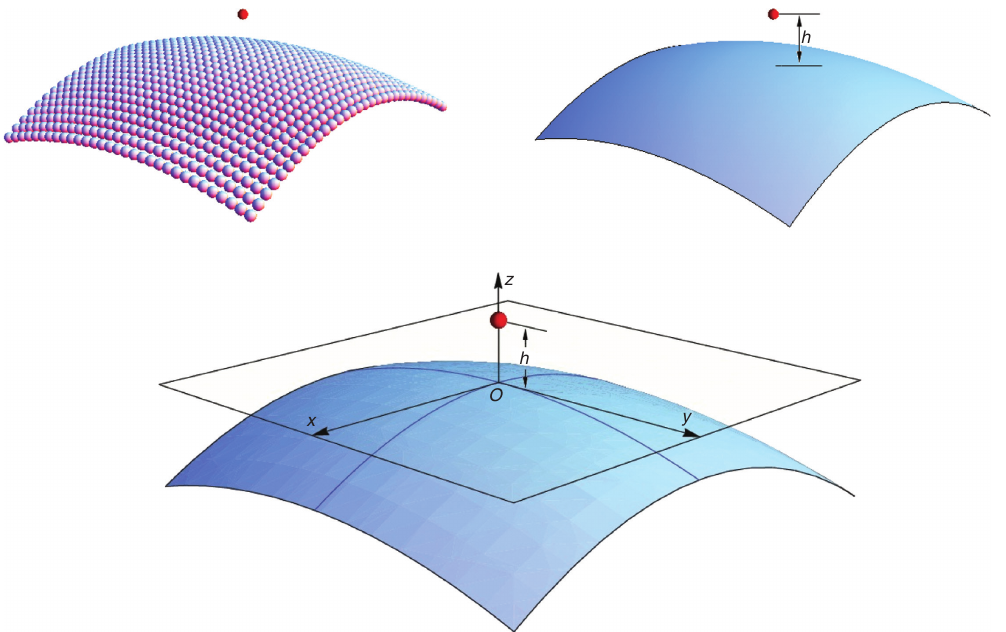
Figure 9 The “outer particle/curved surface” interaction